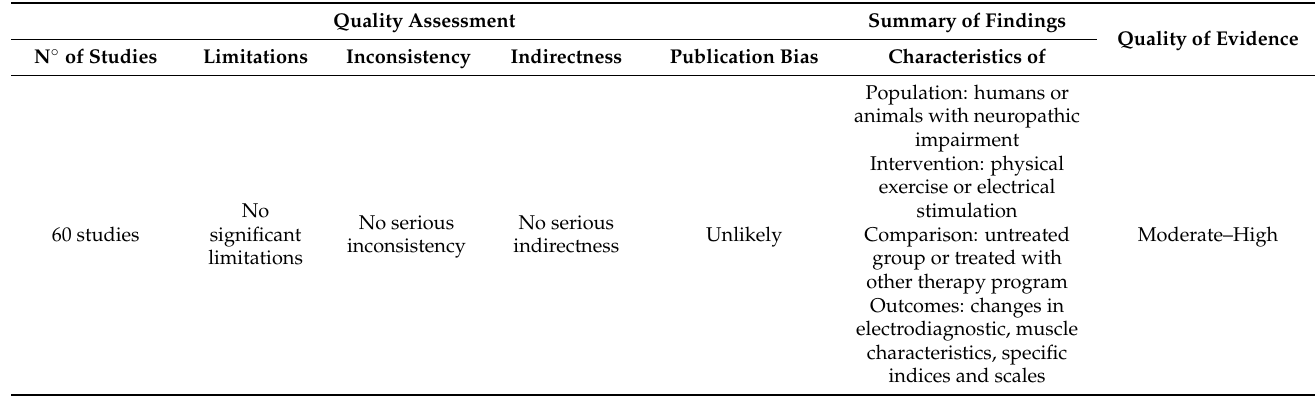
Table 3. Quality of evidence of studies.